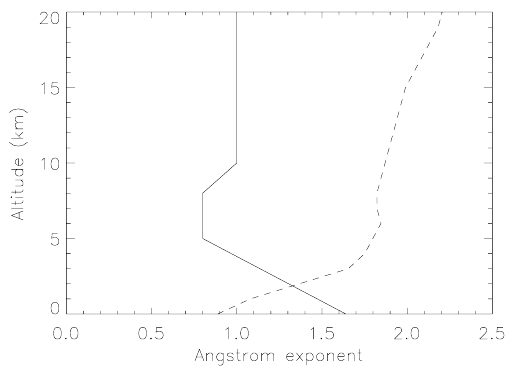
Fig. 3. ˚Angstr¨om exponent as derived from Mattis et al. (2004) (solid) and Marseille et al. (2003)